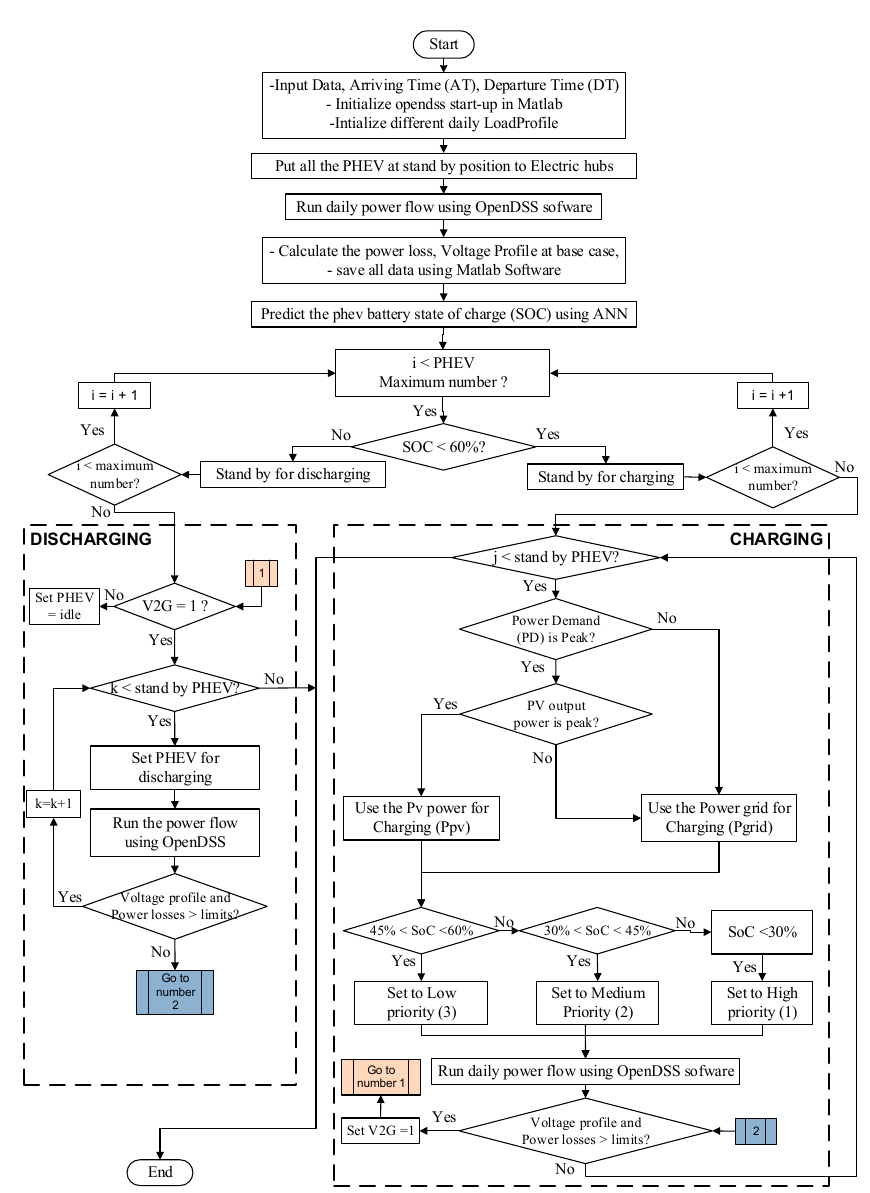
Figure 5. Flowchart of the proposed charging and discharging control algorithm.